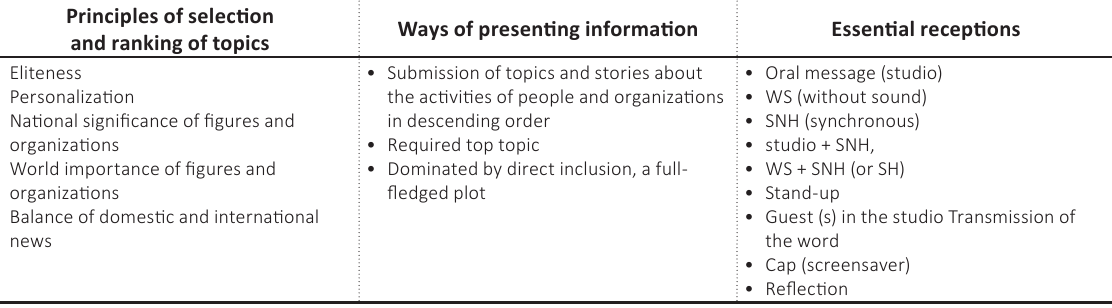
Table 2. Structural model of hierarchical TV layout